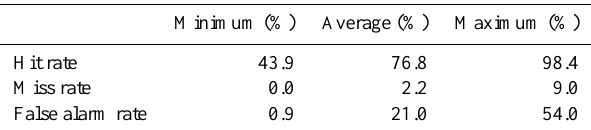
Table 1. Summary of hit, miss, and false alarm rates for 12 scenes in Fig.